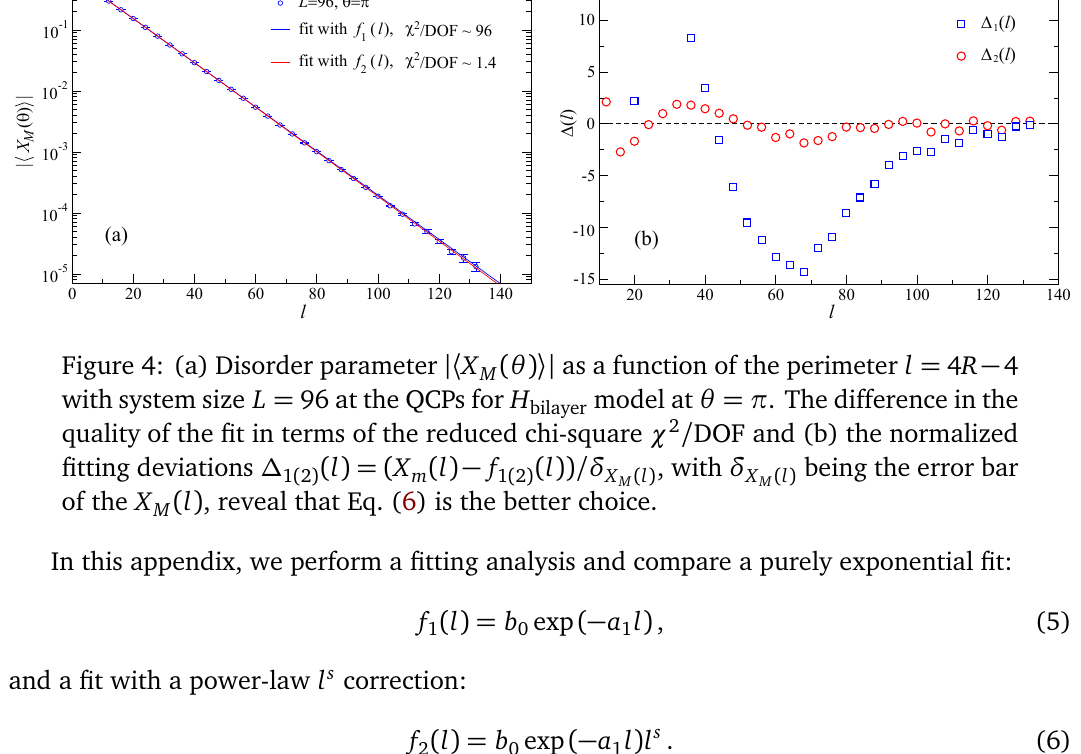
Figure 4: (a) Disorder parameter |〈 X with system size L = 96 at the QCPs for H quality of the fit in terms of the reduced chi-square χ 2 / DOF and (b) the normalized fitting deviations ∆